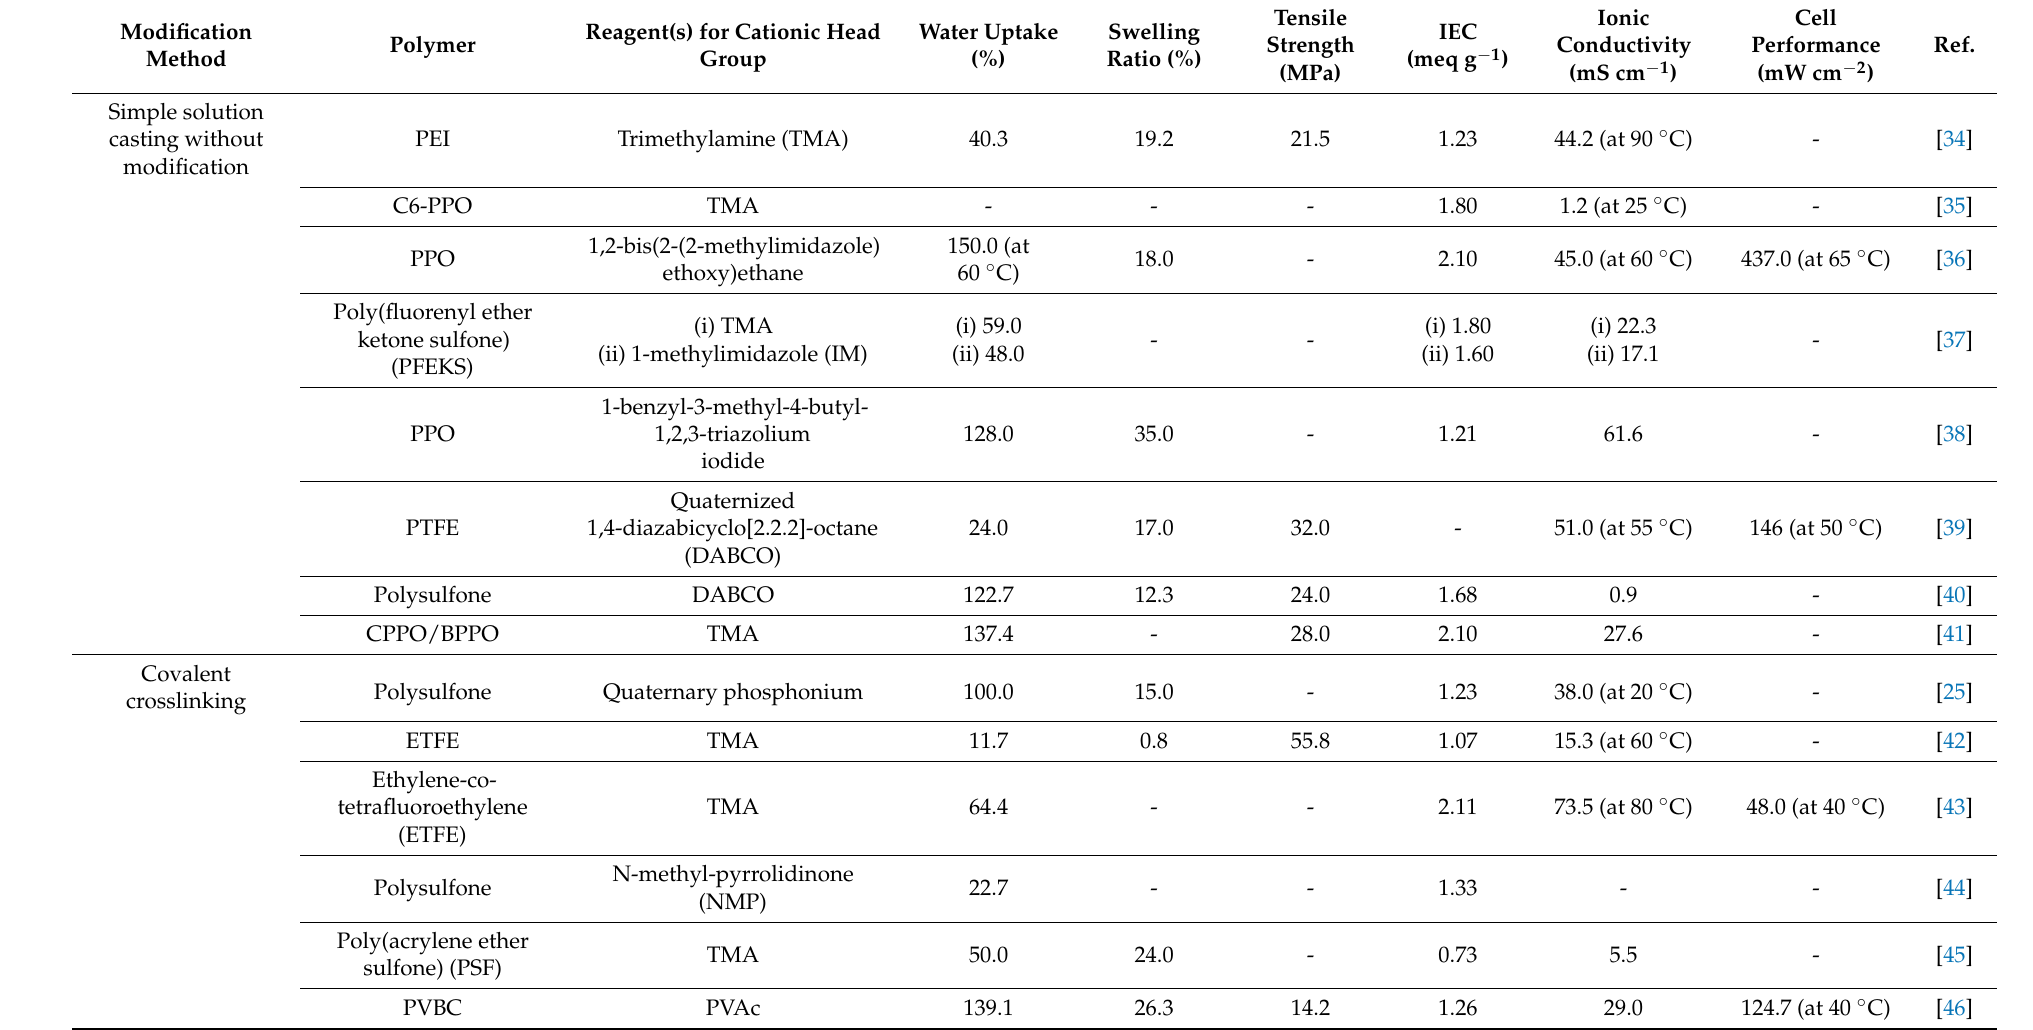
Table 1. Properties of anion exchange membrane (AEM) with different preparation